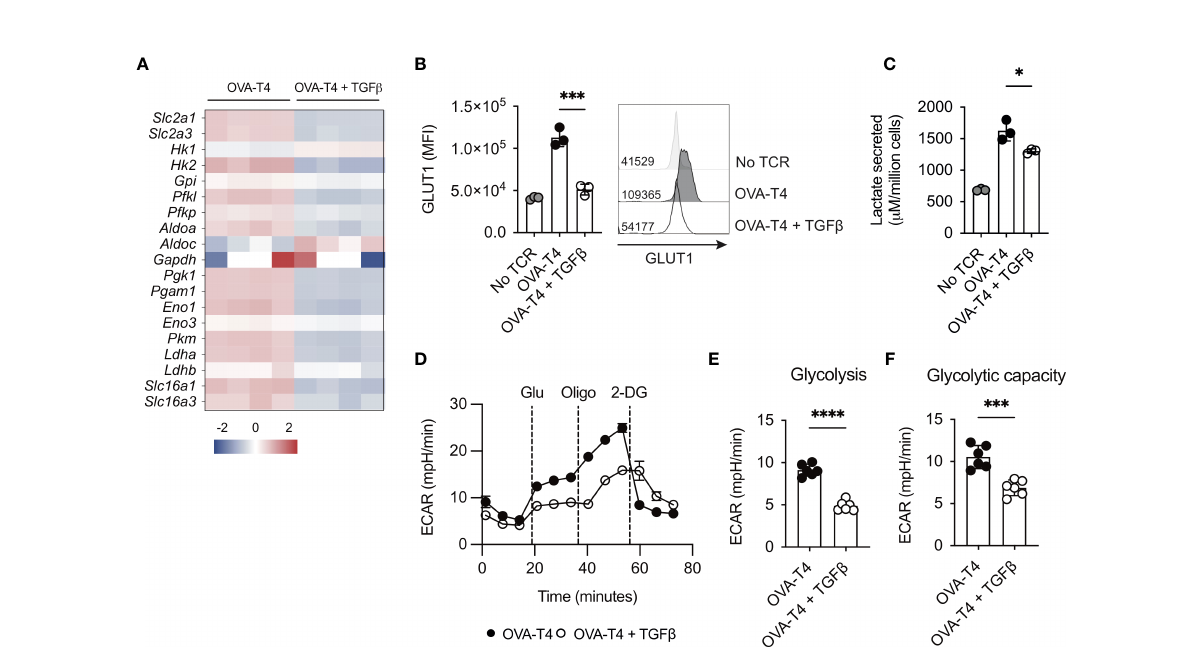
FIGURE 4 TGF b impairs CD8 + T cell glycolytic metabolism OT-I TCR transgenic T cells were stimulated with SIITFEKL (OVA-T4) peptide in the presence or absence of TGF b for 24 (A, C) or 48 (B, D-F) hours. (A) The heatmap shows log 2 fold changes in expression of glycolytic enzyme-encoding genes as determined by RNA-sequencing. Levels of surface expression of glucose transporter (GLUT)1 (B) were determined by fl ow cytometry. For fl ow cytometry analyses data shown represent mean fl uorescence intensity (MFI) values. Individual data points represent technical replicates (n=3) from 1 of 3 repeated experiments. (C) Lactate secretion was determined by analysis of deproteinated culture supernatants using a luminescent assay. Individual data points represent biological replicates (n=3) from 1 of 4 repeated experiments. (D) Seahorse metabolic analysis determined extracellular acidi fi cation rates (ECAR) of OT-I T cells. Dotted vertical lines represent injection times for glucose (Glu), oligomycin (Oligo) and 2-deoxyglucose (2-DG) in the Glycolytic Stress Test ™ . Levels of Glycolysis (E) were calculated by subtracting background ECAR values from those determined following glucose injection, whilst glycolytic capacity (F) represent ECAR values following oligomycin injection. For Seahorse metabolic analyses, error bars represent SD and individual data points represent technical replicates (n=6) from 1 of 4 repeated experiments. NS – not signi fi cant, * p<0.05, *** p<0.001, **** p<0.0001 as assessed by 1-way ANOVA, with Tukey ’ s multiple comparisons test (B, C) or Student ’ s t- test (E, F)